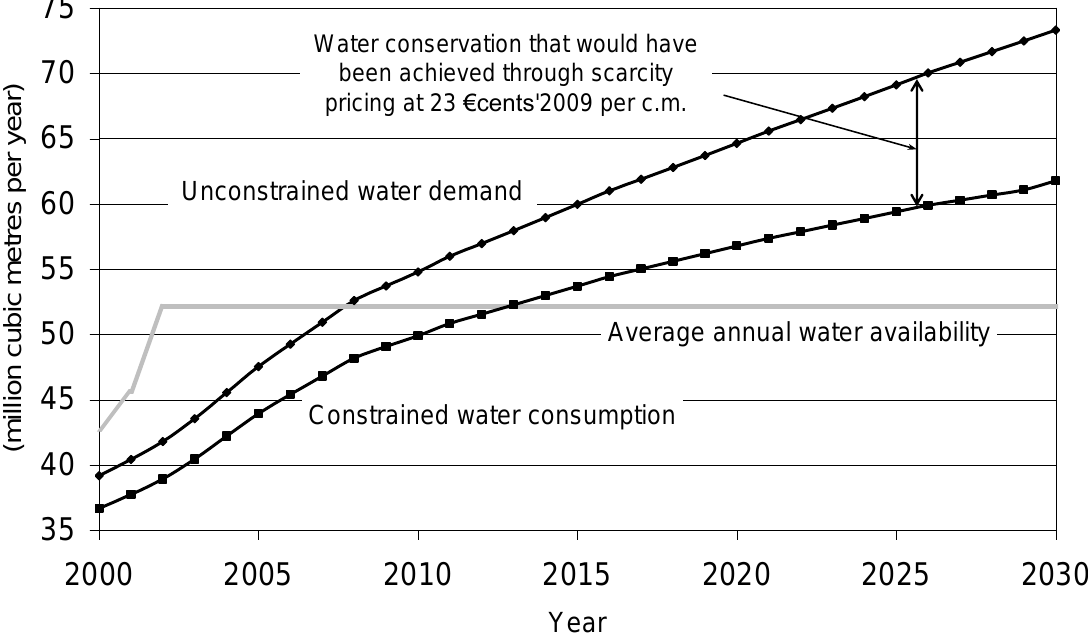
Figure 4. Evolution of optimal water consumption quantities for the period 2000–2030 if efficient pricing had been implemented in the year 2000. Note: Annual water availability takes into account the desalination plants of Dekelia (which started operating in 1997) and Larnaca (which became fully operational in